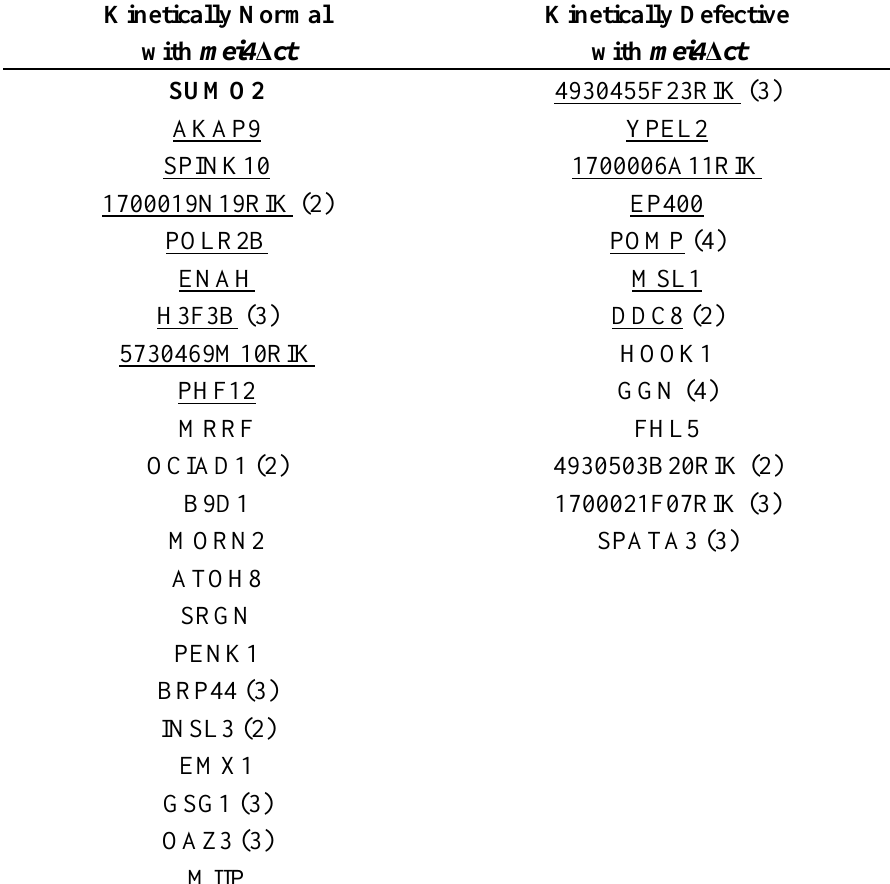
Table 1. Proteins Identified in Two Hybrid